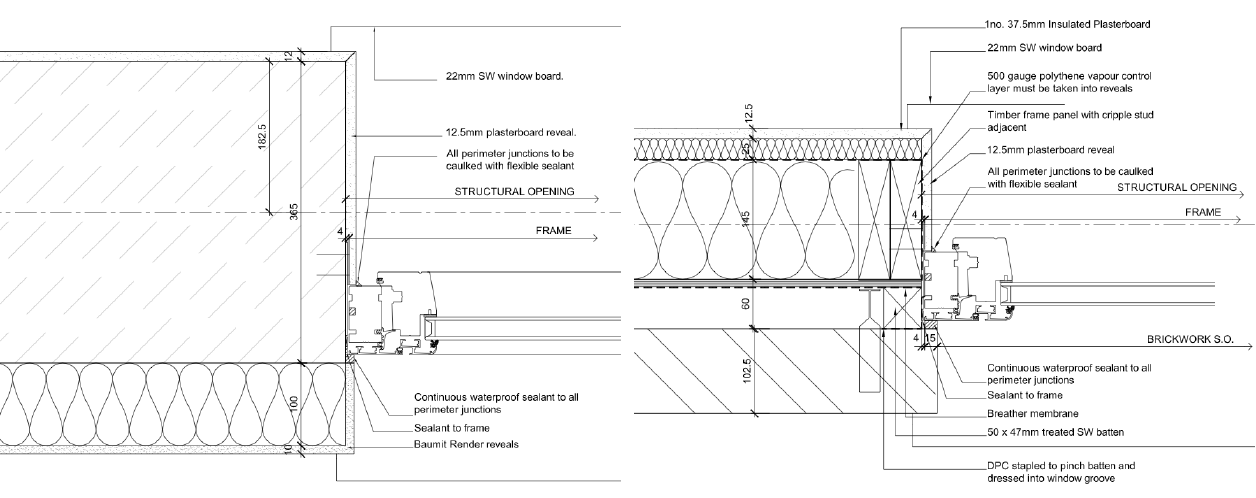
Figure 3. Plot 1 ( left ) and Plot 3 ( right ) wall